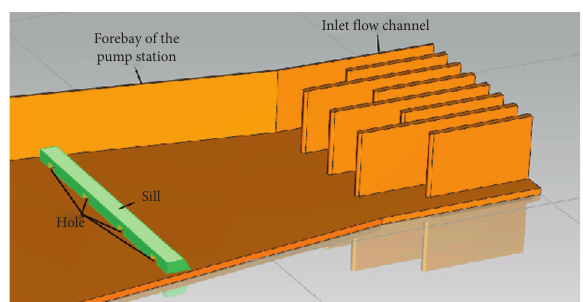
Figure 4: Schematic diagram of the sill